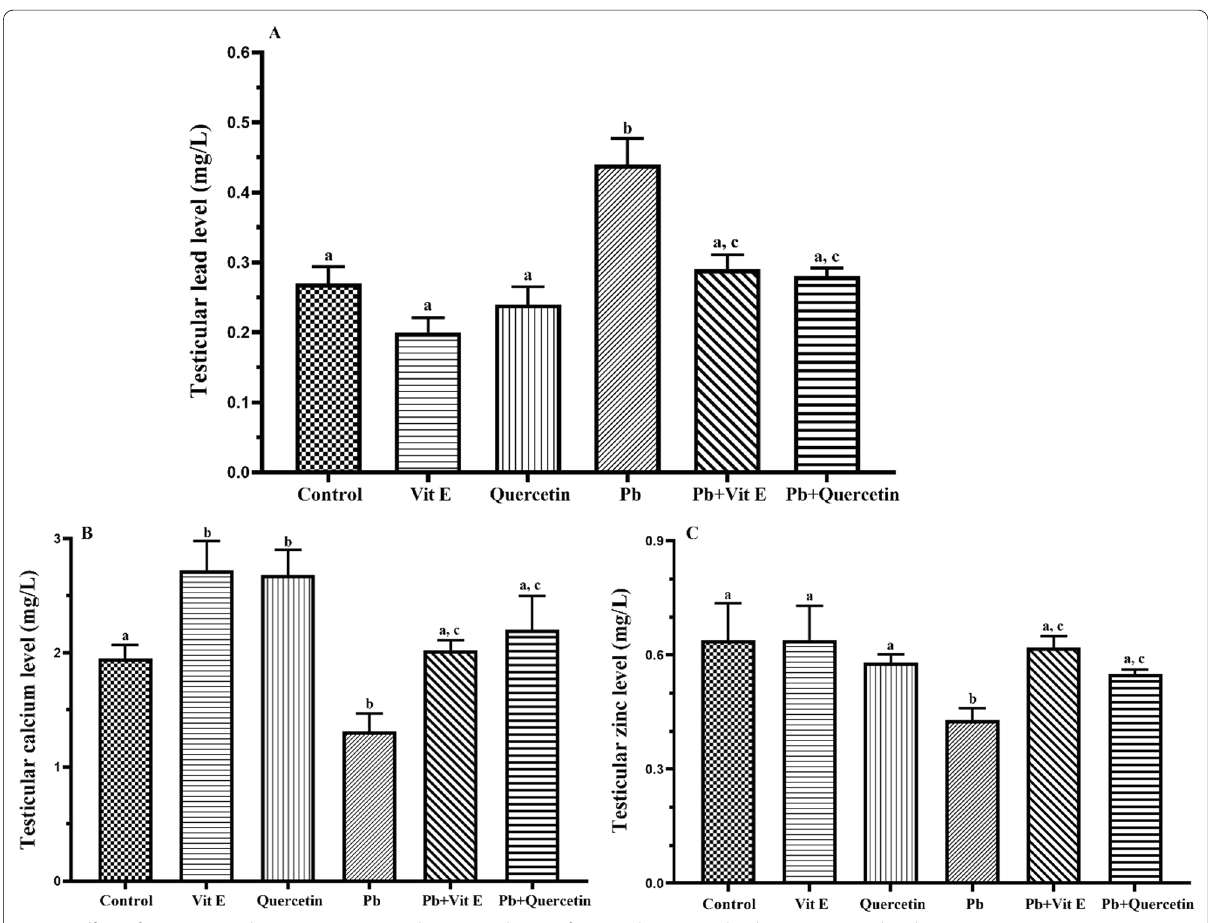
Fig. 2 Effect of vitamin E and quercetin on testicular accumulation of micro‑elements in lead acetate treated male Wistar rats. Bars represent mean SEM, means bearing different superscripts between groups differ significantly at p < ±